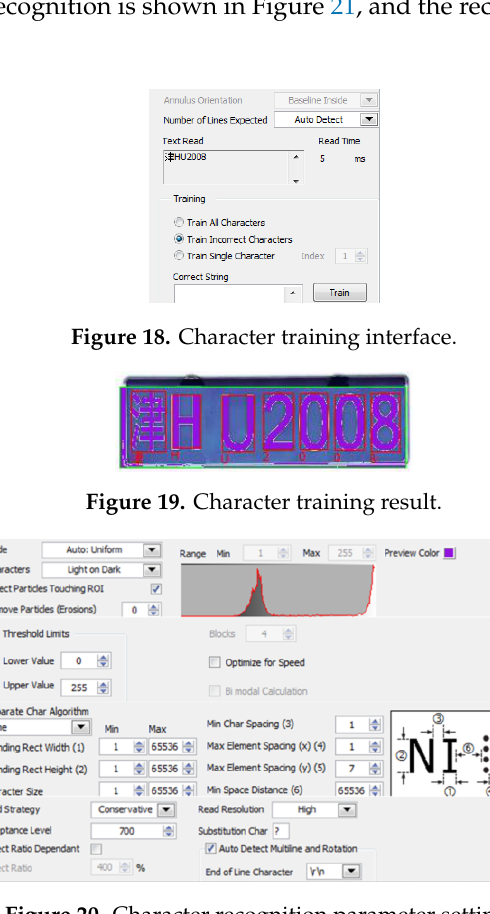
Figure 20. Character recognition parameter settings.